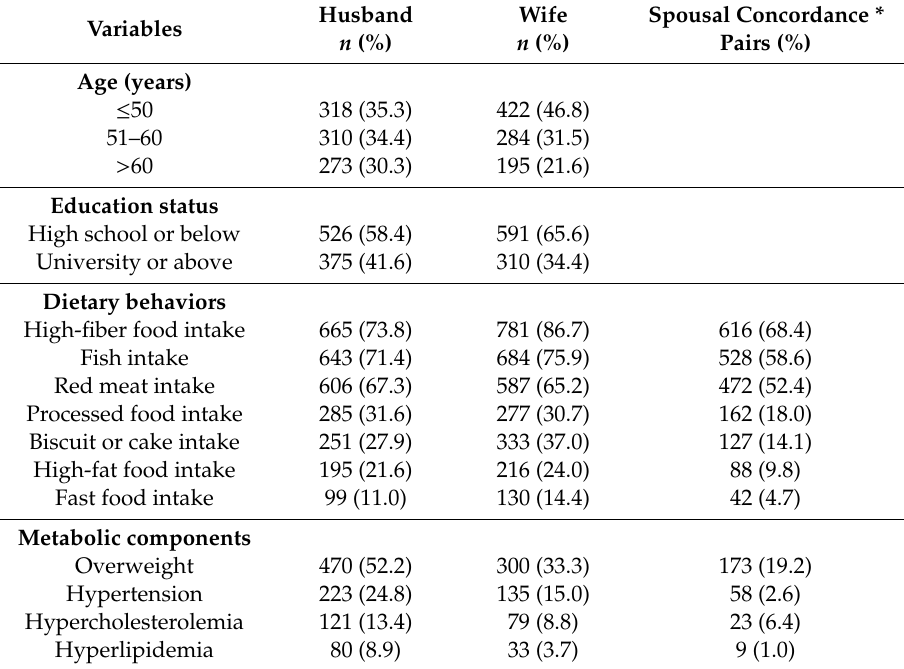
Table 1. Sociodemographic characteristics of the participants ( n = 901